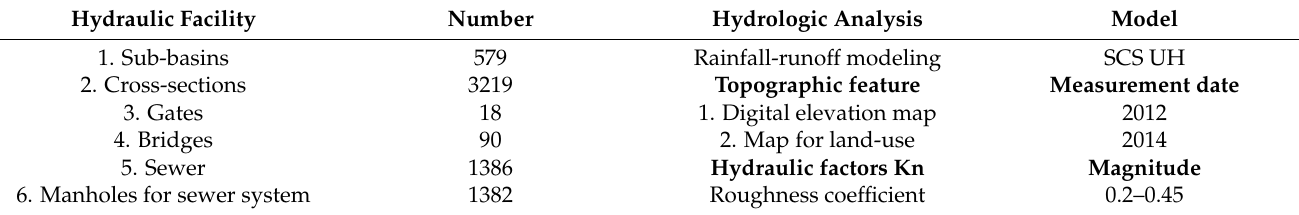
Figure 4. Locations and DEM as well as QPE grids (blue circle) within the study area, Nankan River watershed (yellow region) [18]. Table 3. Summary for hydraulic facilities, hydrological analysis, and topographic features used in the SOBEK model for the Nankan River